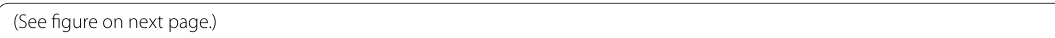
(See figure on next Fig. 2 Stratigraphic column of well Humilly-2 with location of the potential reservoirs investigated. Location of investigated samples HU taken from cores and position of the six interpreted regional seismic reflectors. Cores were extracted in four depth intervals (I, II, III, and V in column “Core”). The depth interval IV is partially represented by samples from literature while the depth interval V corresponds to 3 sub-intervals: Permo-Carboniferous (VII), Lower Triassic (VI), and Middle Triassic (V) (see text for explanations). Anis. Anisian, Hauteriv. Hauterivian, A. Aleian, Batho. Bathonian, Muschelk. Muschelkalk